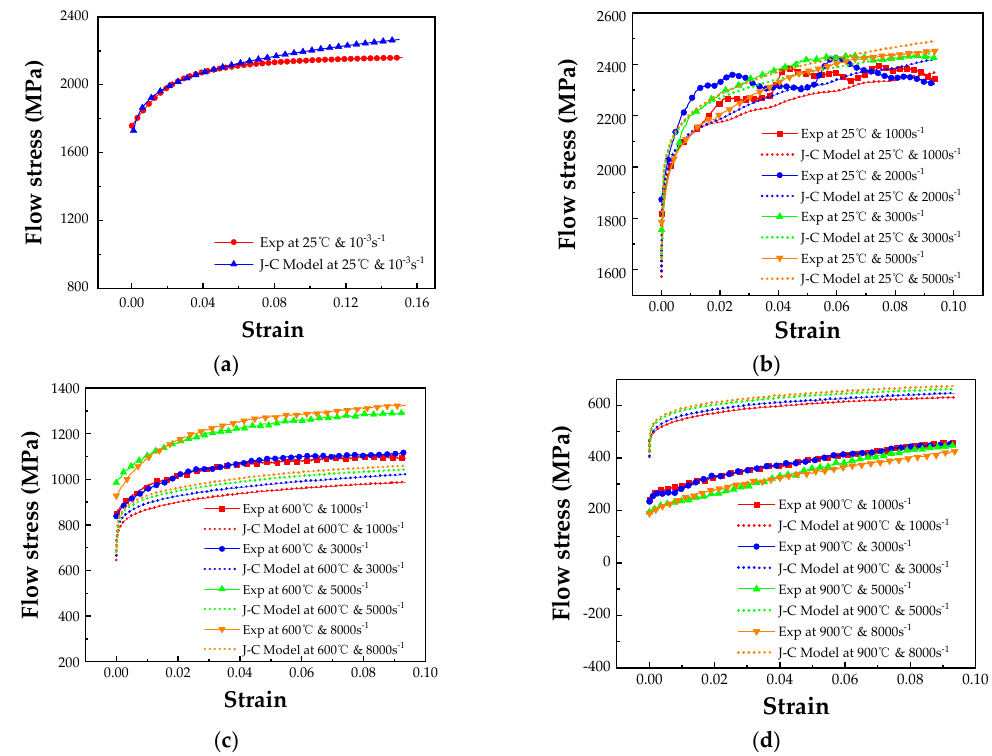
Figure 6. Comparison of experimental data and J-C model ( a ) quasi-static at 25 °C; ( b ) at different strain rate and 25 °C; ( c ) at different strain rate and 600 °C; ( d ) at different strain rate and 900 °C.